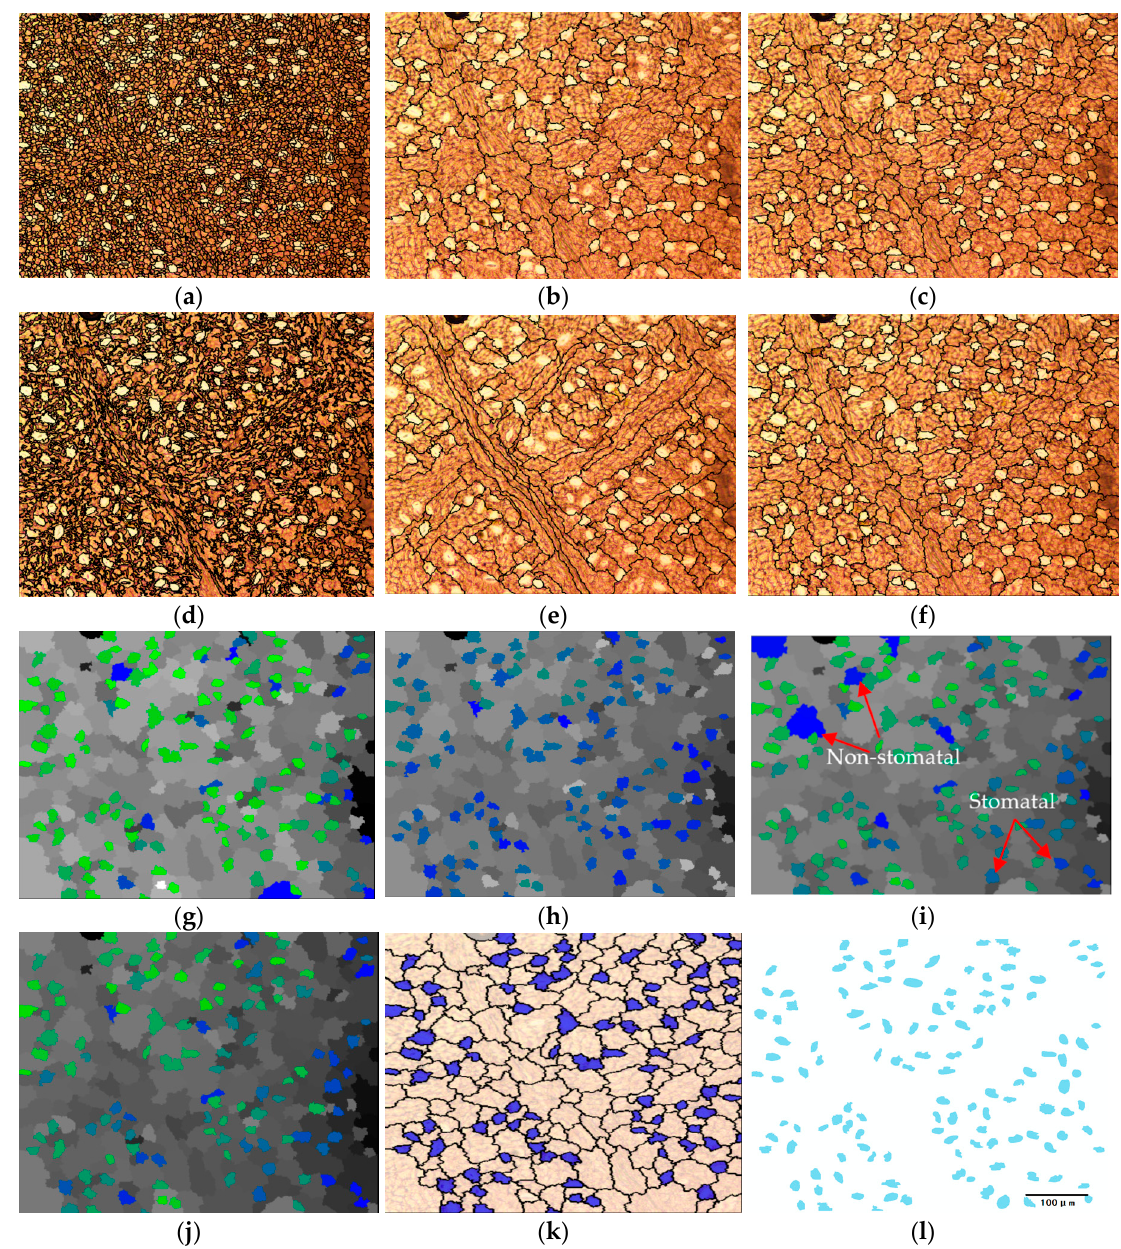
Figure 7. Segmented and extracted process of a stomatal image. ( a – c ) Partitioning scales of 30, 180, and 120; ( d ) shape parameter 0.1 and compactness parameter 0.9; ( e ) shape parameter 0.9 and compactness parameter 0.1; ( f ) shape parameter 0.7 and compactness parameter 0.9. ( g – l ) Brightness characteristics: blue band, green band, red band, brightness value + red band, brightness value + red band + shape feature ( Ailanthus altissima used as an example).